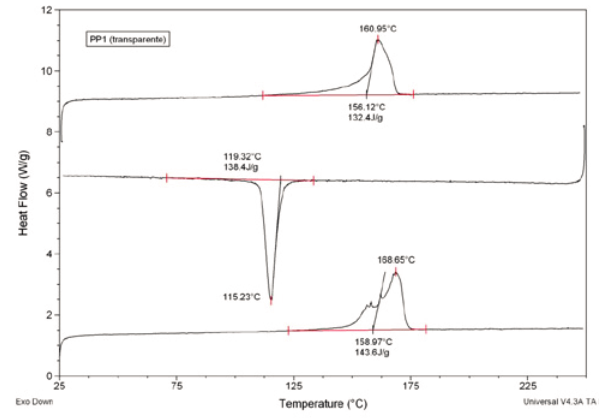
FIGURE 9 - Differential Scanning Calorimetry of Group 2 (Conventional mesh). The bottom curve represents the fusion curve. In the middle the crystallization point and peak. At the top of the graph is the second heating with a peak of